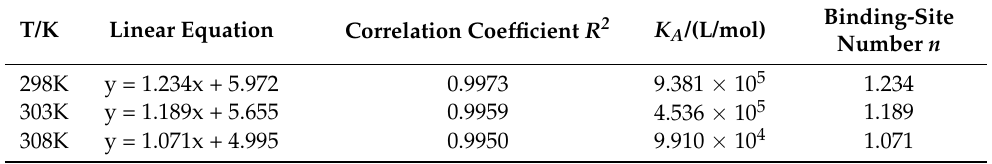
Table 2. Binding constants and thermodynamic parameters of TRP and MC under different